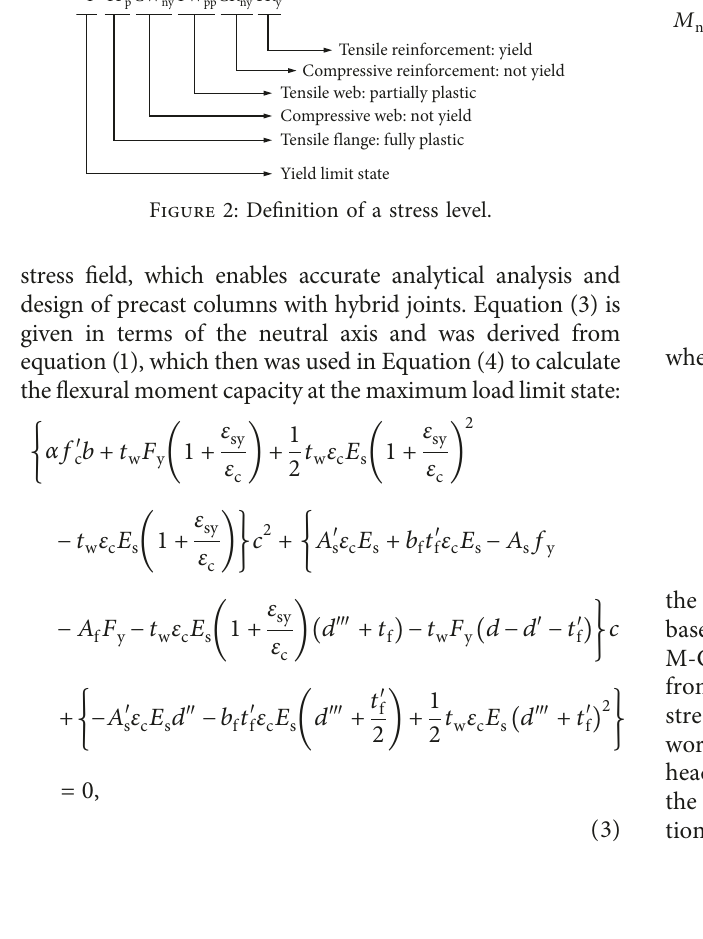
Figure 1: Column test specimens [17]. (a) Specimen #1: conventional concrete column. (b) Specimen #2: column with the steel section and headed studs at the joint. (c) Specimen #3: concrete column encasing a steel section. Y-TF p CW ny TW pp CR ny TR y